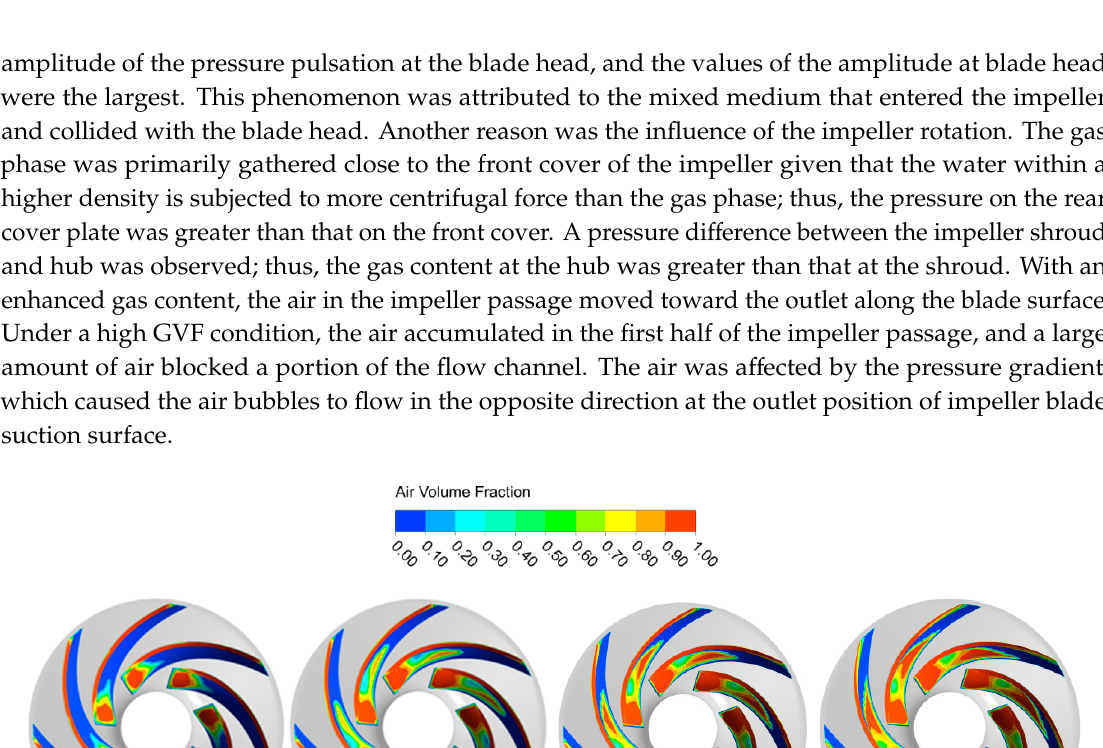
Figure 10. Distribution of GVF on the blade of the second impeller for different gas contents.